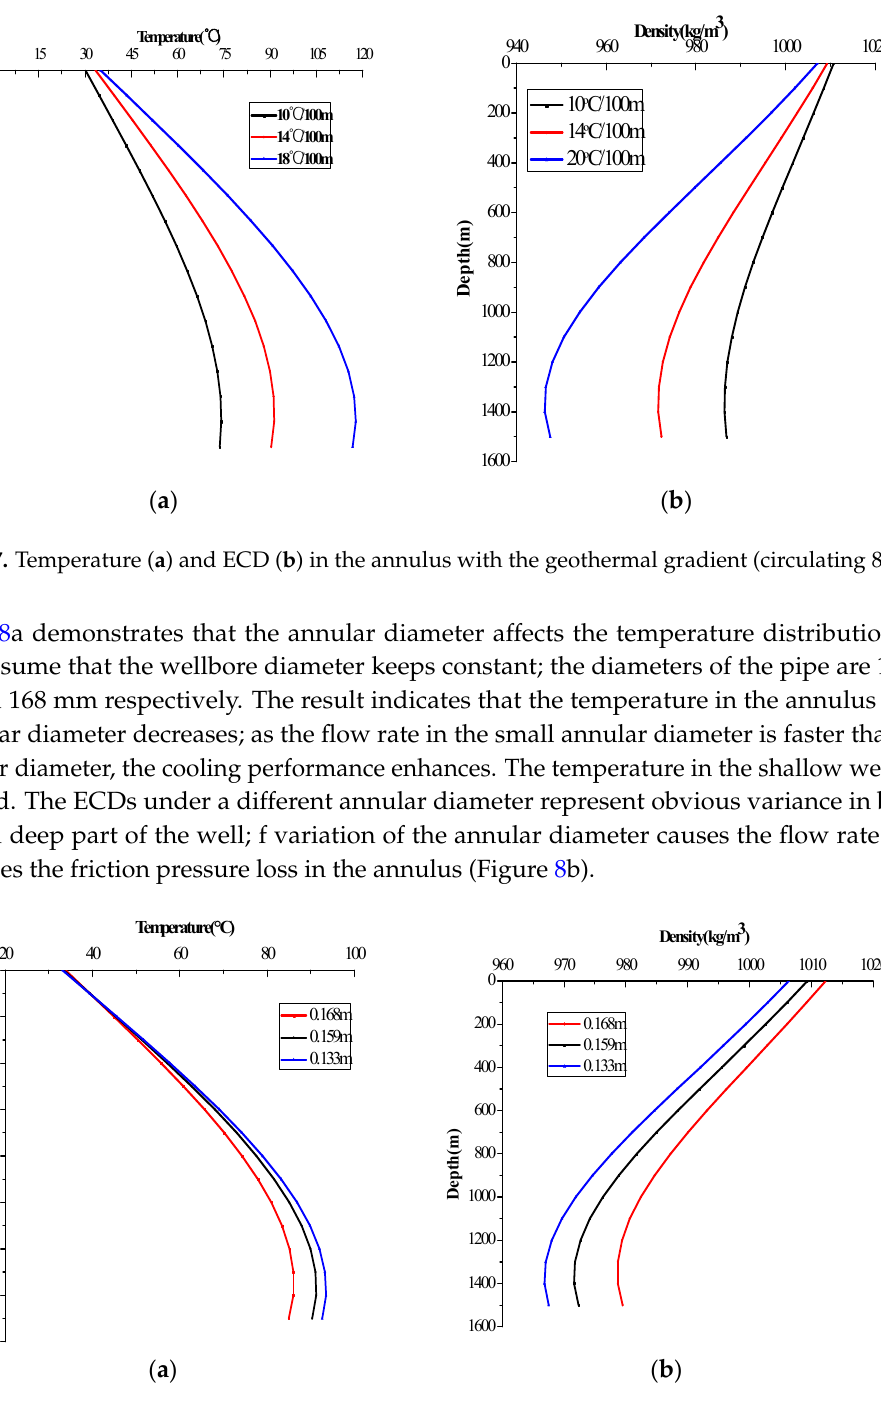
Figure 8. Temperature ( a ) and ECD ( b ) in the annulus with the outer diameter of the pipe (circulating 8 h).